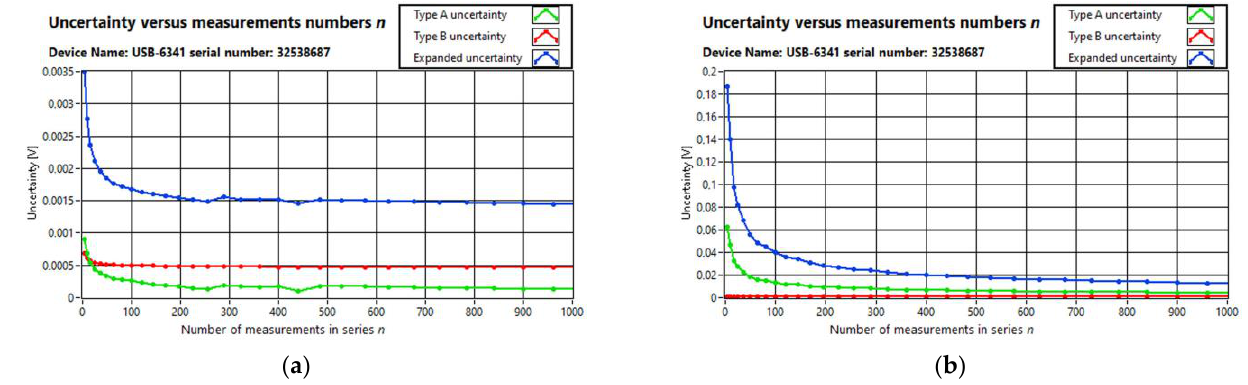
Table 3. Comparison of uncertainties for tested measurement modules for n = 4, 196, 1024.